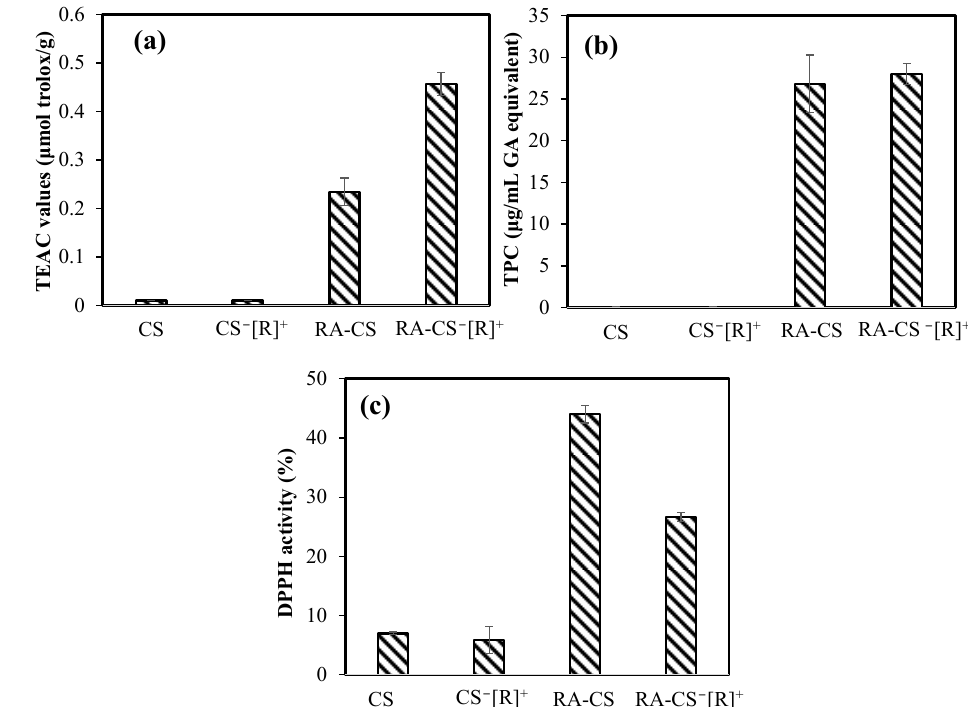
Figure 7. The antioxidant capacities of bare and RA-loaded CS microgels and polyelectrolyte CS − [R] + microgels ( a ) via Trolox equivalent antioxidant capacity (TEAC) test, ( b ) gallic acid (GA) equivalent total phenol content (TPC) at 1000 μ g/mL concentrations of microgels, and ( c ) DPPH radical-scavenging assay for 3.33 mg/mL concentrations of the microgels.